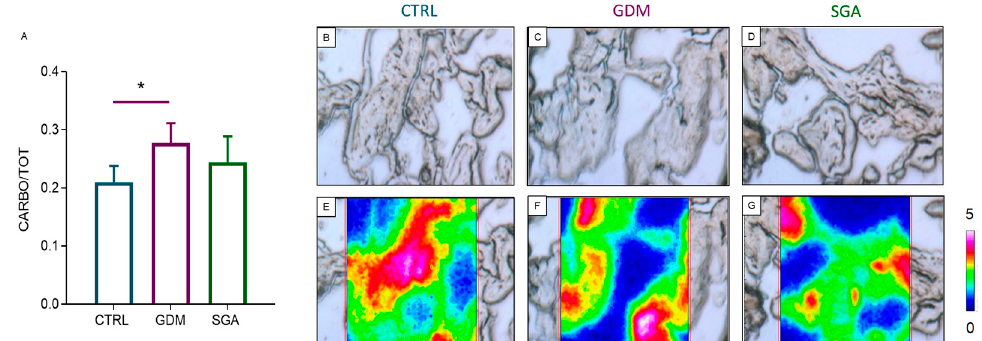
Figure 8. FTIRI analysis of the carbohydrate content in CV sections of CTRL, GDM, and SGA experimental groups. ( A ) Statistical analysis of the CARBO/TOT band area ratio, corresponding at the amount of total carbohydrates (TOT was the sum of the areas of all the bands in the 1350–1000 cm − 1 range). Values are reported as mean ± SD of five independent samples ( n = 5). Asterisks indicate significant differences between CTRL (control group, blue), GDM (gestational diabetes mellitus, purple), SGA (small-for-gestational-age, green) groups (* p < 0.05). ( B – D ) Microphotographs of representative sections of CTRL, GDM, and SGA groups, and ( E – G ) corresponding false-color images showing the topographical distribution of carbohydrates within the mapped areas; absorbances ranged from white/pink (representing the highest values) and blue/black (representing the lowest ones).